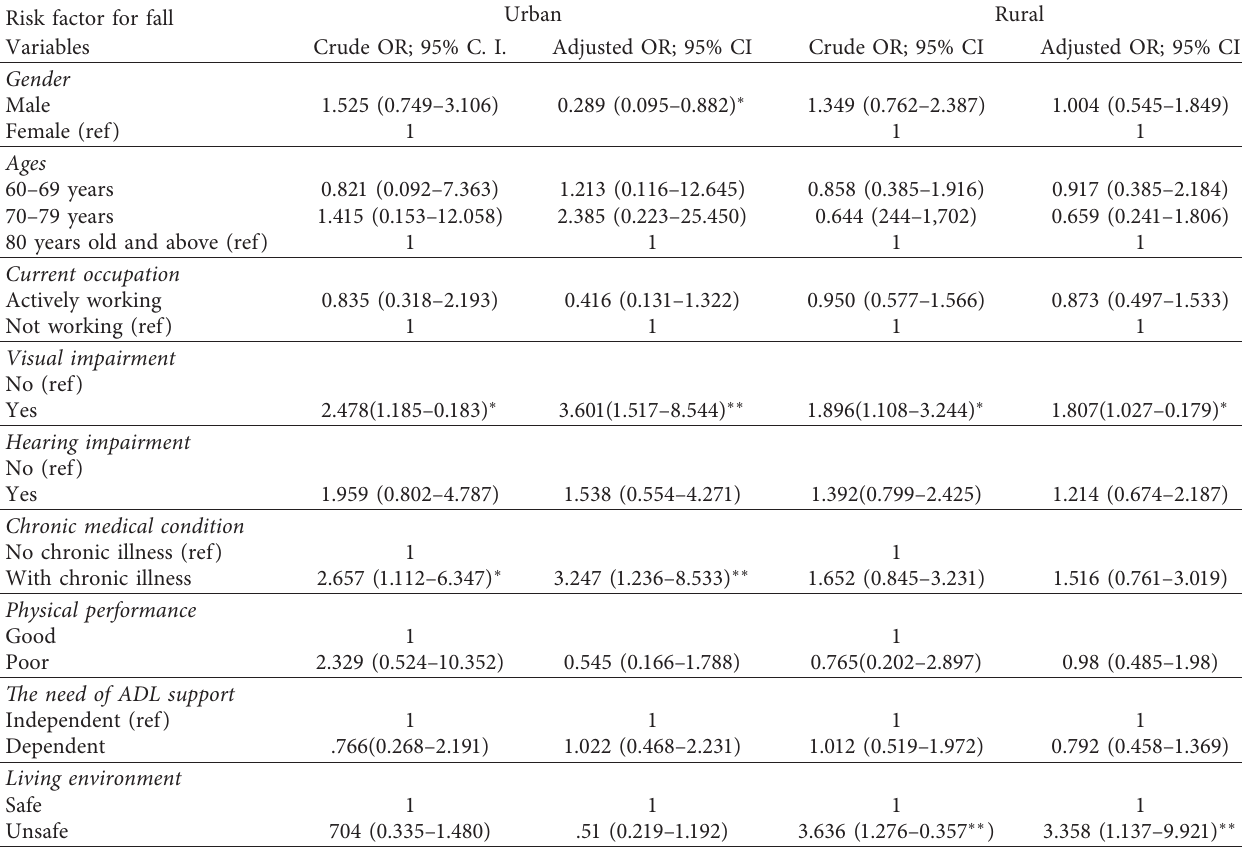
Table 2: Risk of falling among older adults in urban and rural